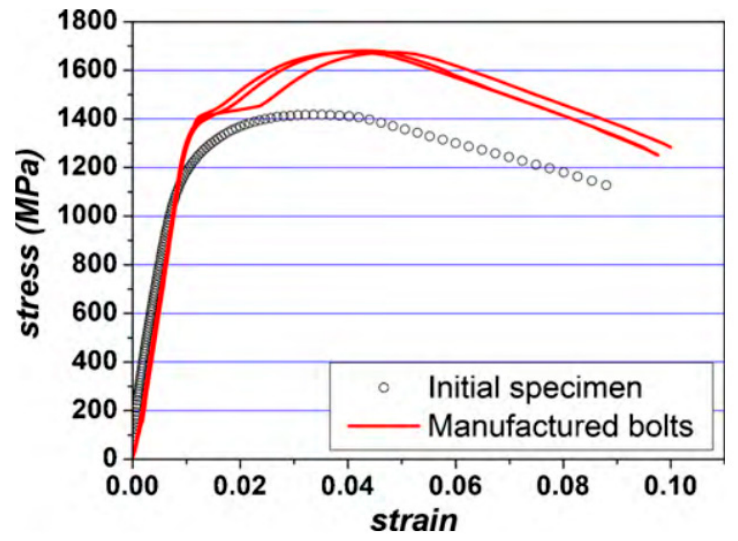
Figure 6. Stress–strain behaviour of high-carbon steel bolt compared to raw material [87].